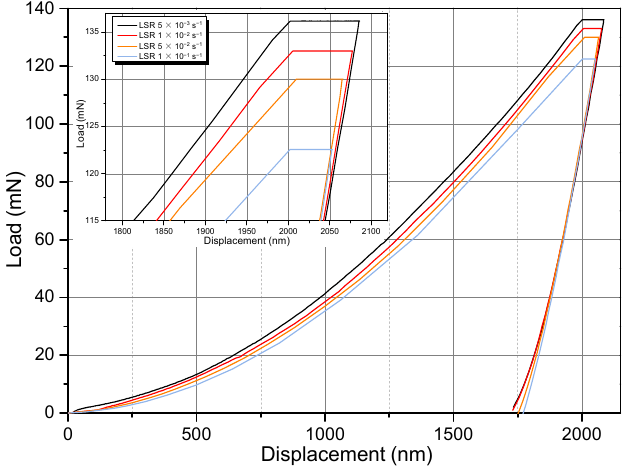
Figure 4. Load-displacement curves of the RS NC Mg–Gd–Y–Zr alloy under various loading strain rates.